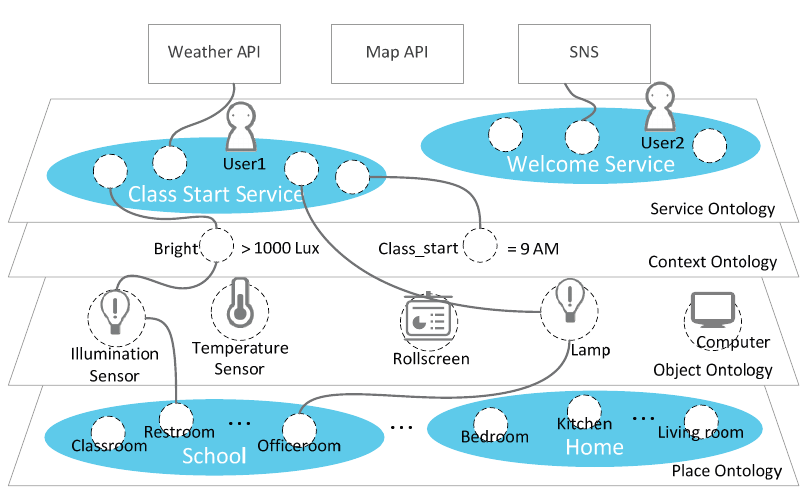
Figure 2. Base-ontology overview.